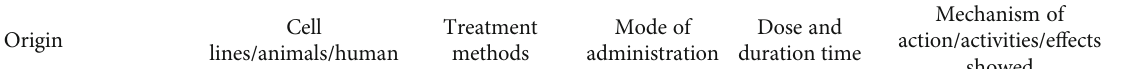
Table 1: The chemopreventive e ff ect and potential mechanism of dihydromyricetin in